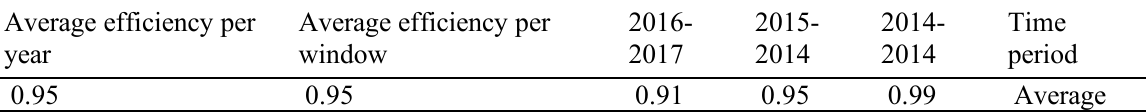
Table 4. Results of efficiency assessment with window data envelopment analysis in Zehak County